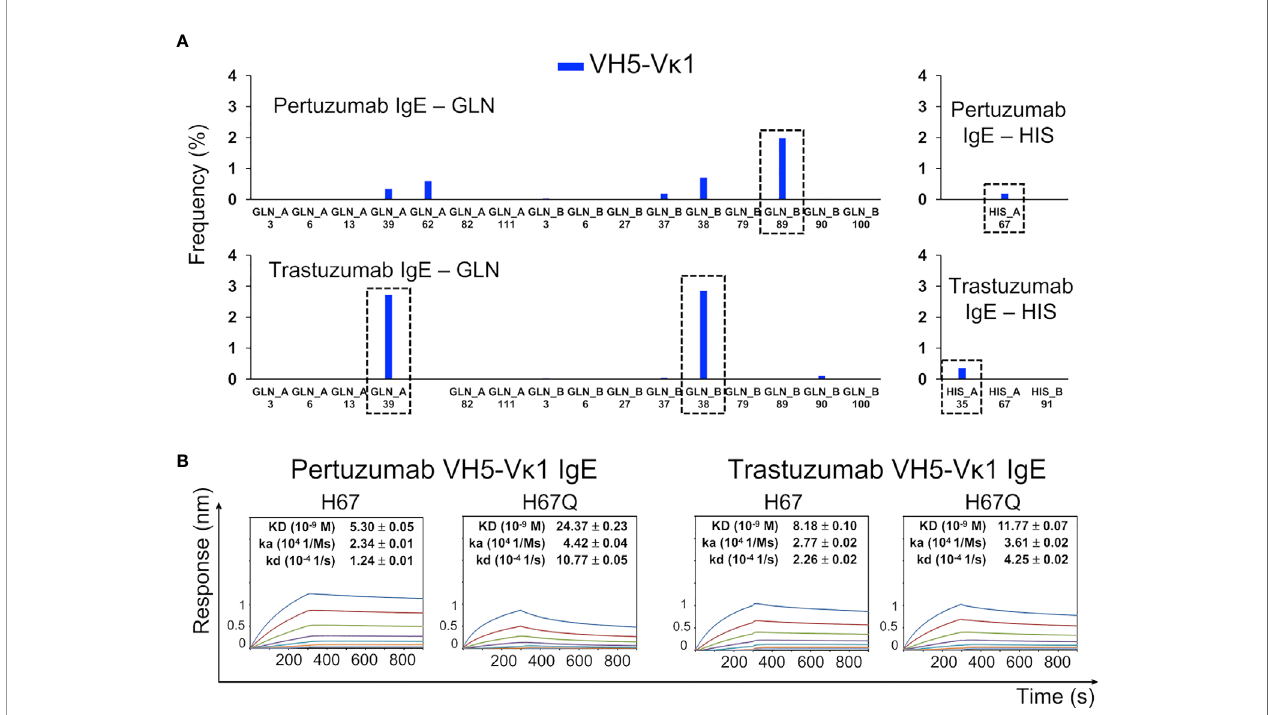
FIGURE 3 | The Ni-NTA binding region of the Pertuzumab VH5 – V k 1 IgE. The main residue for the interaction is H67 of VH5 FWR3, whereas for Trastuzumab VH5 – V k 1 IgE, it is at the Q-stretch containing VH5 Q39 at FWR2. (A) Distribution of the Ni-NTA docked conformers showing all the glutamine (GLN) and histidine (HIS) present in the V-region of the Pertuzumab and Trastuzumab VH5 – V k 1 IgE variants. The predominant binding residue locations are highlighted in dashed boxes. (B) KD of the Pertuzumab and Trastuzumab VH5 – V k 1 IgE variants including H67Q